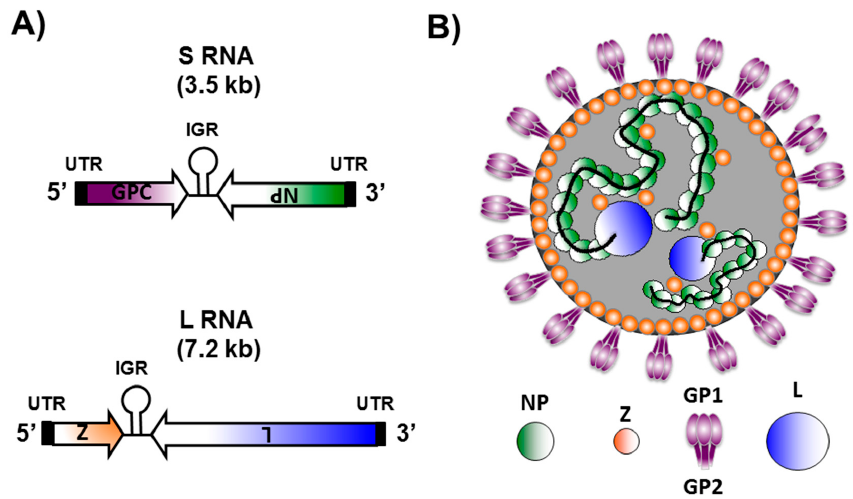
Figure 1. Arenavirus genome organization and virion structure. ( A ) genome organization: Arenaviruses are enveloped viruses with a single ‐ stranded, bi ‐ segmented RNA genome of negative polarity. Each of the two viral RNA genome segments uses an ambisense coding strategy to direct the synthesis of two viral polypeptides in opposite orientation. The Small (S) RNA segment (3.5 kb, top) encodes the viral glycoprotein precursor (GPC, purple) and nucleoprotein (NP, green). The Large (L) RNA segment (7.2 kb, bottom) encodes the RNA ‐ dependent RNA polymerase (L, blue) and the small really interesting new gene (RING) finger protein (Z, orange); ( B ) virion structure: Arenaviruses are surrounded by a lipid bilayer containing the post ‐ translationally processed viral glycoprotein involved in receptor binding (GP1) and viral cell entry (GP2). Underneath the lipid bilayer is a protein layer composed of the Z protein, which plays a major role in viral assembly and budding, and is the arenavirus counterpart of the matrix protein present in other enveloped negative ‐ stranded (NS) RNA viruses. The core of the virus is made of a viral ribonucleoprotein (vRNP) complex, composed of the viral genome segments encapsidated by the viral NP. Incorporation of the vRNPs into newly nascent virions is mediated by NP ‐ Z interaction. Associated with the vRNPs is the L polymerase protein that, together with NP, are the minimal components for viral genome replication and gene transcription.